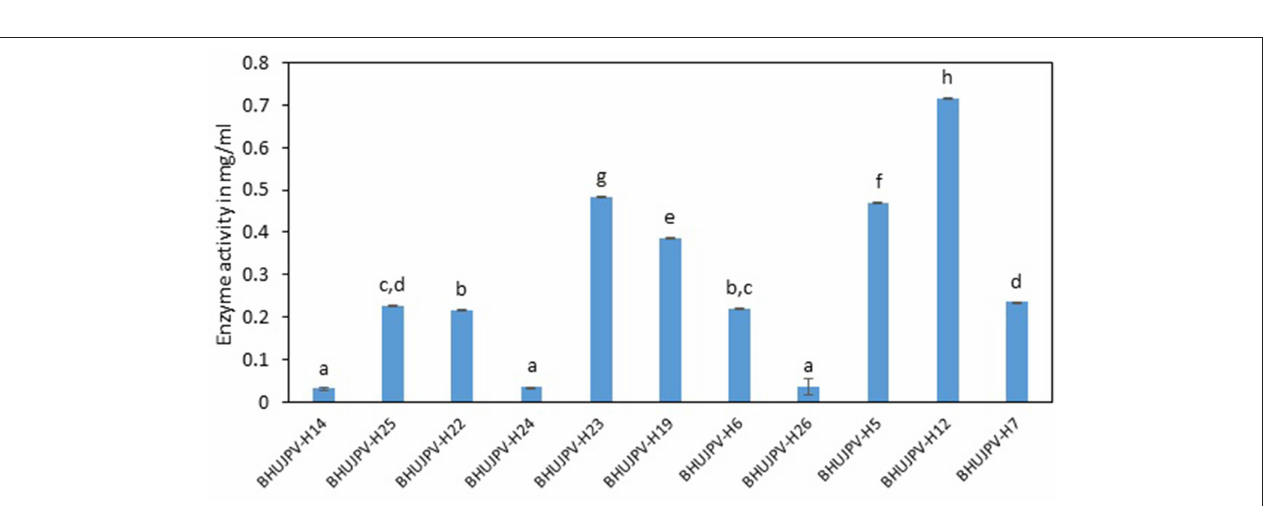
FIGURE 5 | Enzyme activity on wheat straw (Sugars released from sugarcane bagasse). Values are the mean ± SE (standard error). Mean values in each bar with the same alphabet superscript(s) do not differ significantly, but different alphabet superscript is showed significantly different between each treatment by Duncan post hoc test ( p ≤ 0.05).